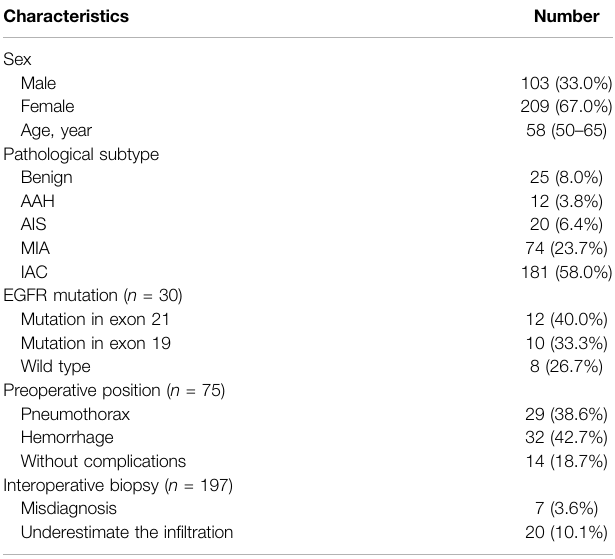
TABLE 2 | Clinical characteristics of